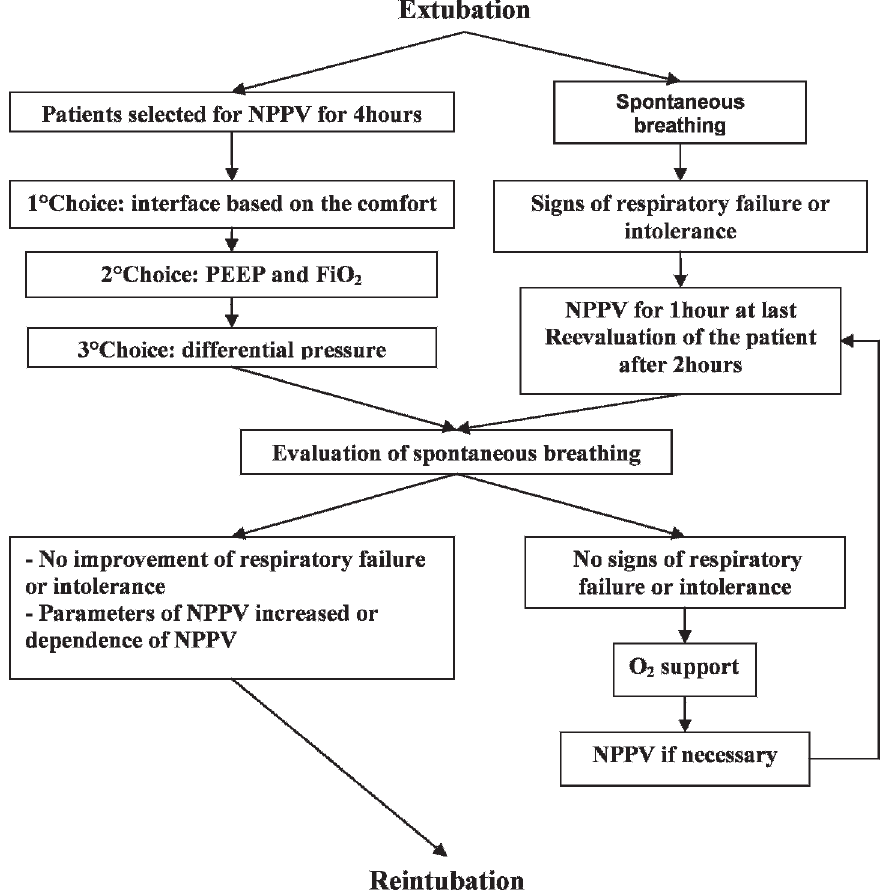
Figure 3 - NPPV use in the intervention group. NPPV non-invasive positive-pressure ventilation; PEEP positive end-expiratory